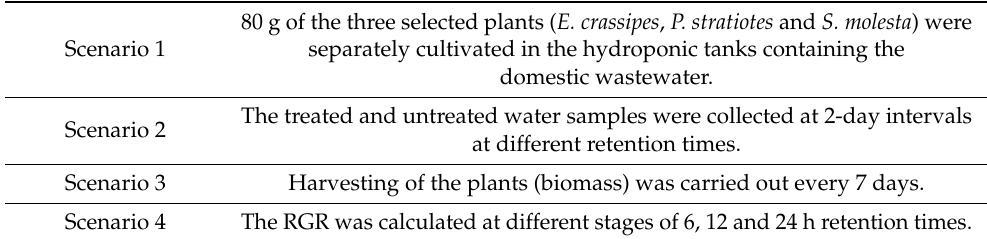
Table 1. Summary of data collection and methodology.